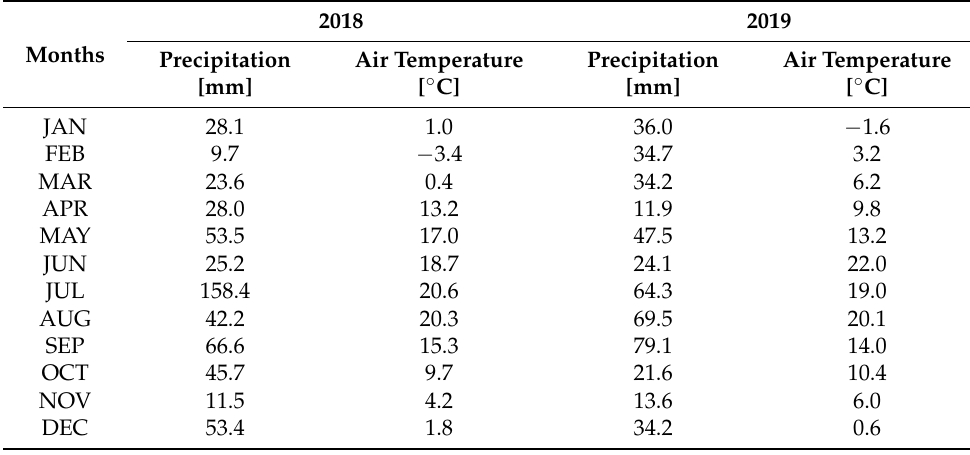
Figure 1. Location of the research area in Experimental Station of the Institute of Agriculture of the Warsaw University of Life Sciences in Skierniewice. Table 1. Monthly precipitation totals and temperature in 2018 and 2019.